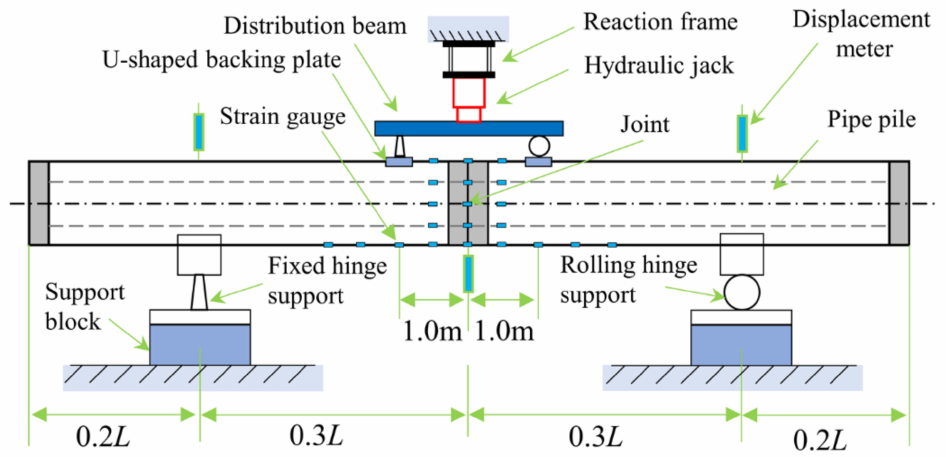
Figure 3. Schematic diagram of bending